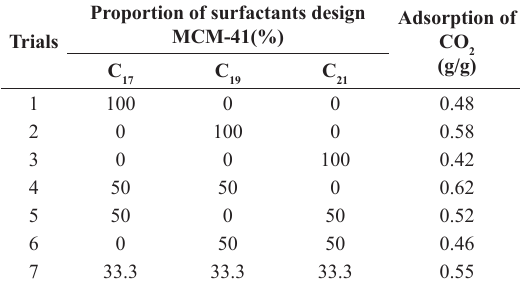
Table 4. Simplex-Centroid mixture